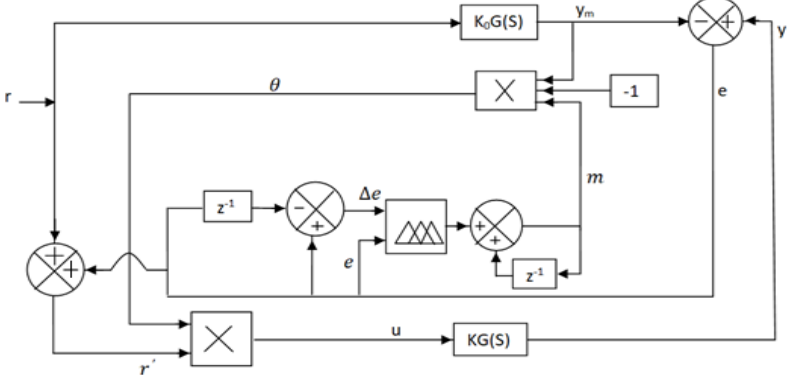
Figure 9. Proposed SFPIMRAC model.